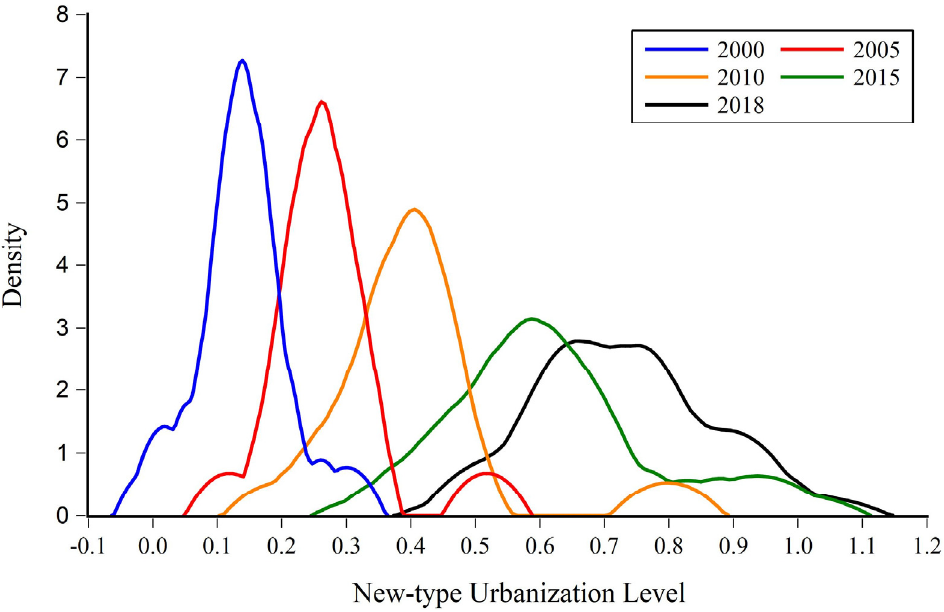
Figure 4. Temporal evolution trend of new-type urbanization levels of the Yangtze River Delta during 2000–2018.